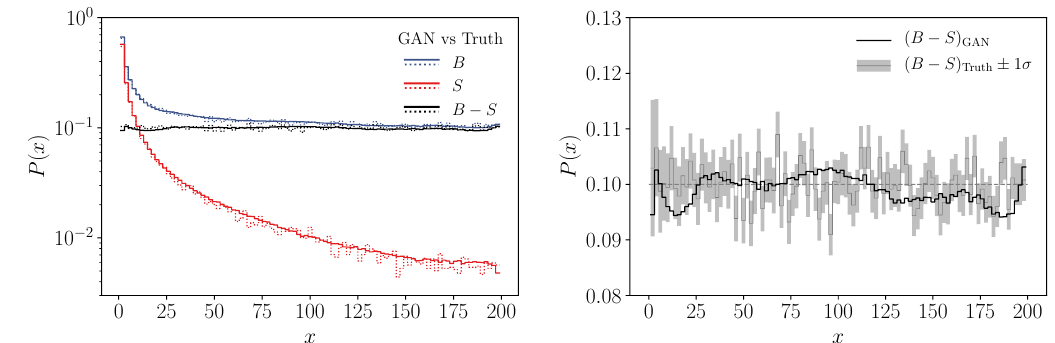
Figure 2: Left: Generated (solid) and true (dashed) events for the two input distri- butions and the subtracted output. Right: distribution of the subtracted events, true and generated, including the error envelope propagated from the input